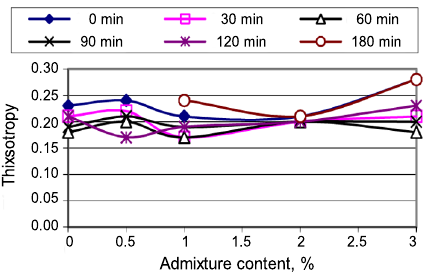
Fig. 16. Thixotropy of cement paste with CEM I R cement